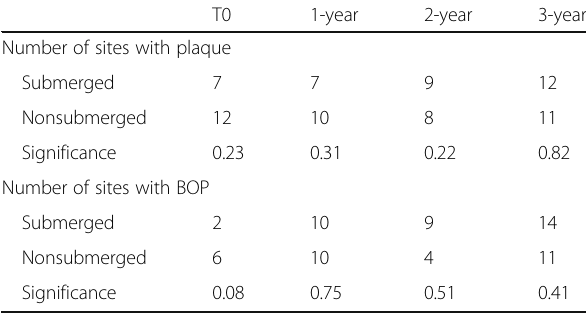
Table 3 Differences in number of sites with plaque and bleeding on probing (BOP) between the two groups during the follow-up period (Wilcoxon signed-rank tests, P >